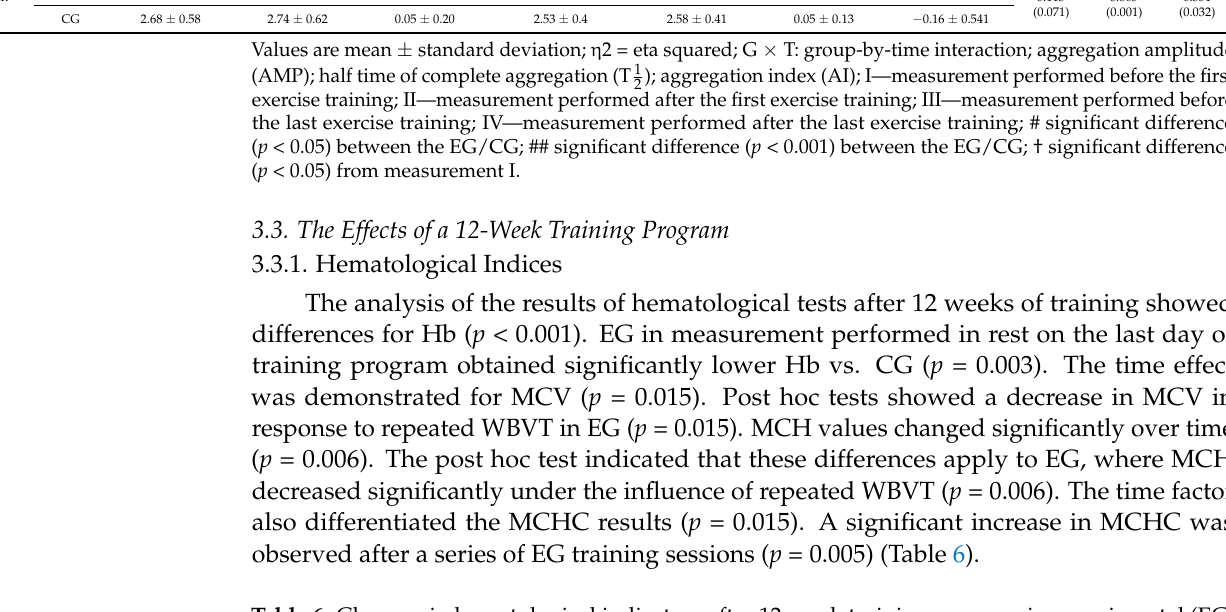
Table 6. Changes in hematological indicators after 12-week training program in experimental (EG) and comparison group (CG) and at an interval of 3 months in control group